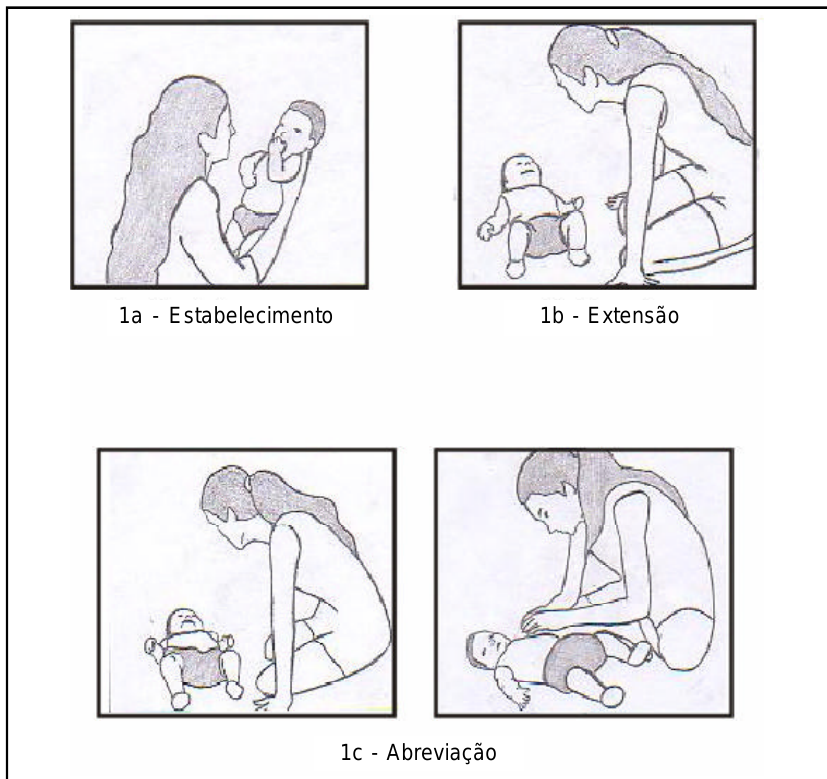
Figura 1 . Ilustrações face-a-face.